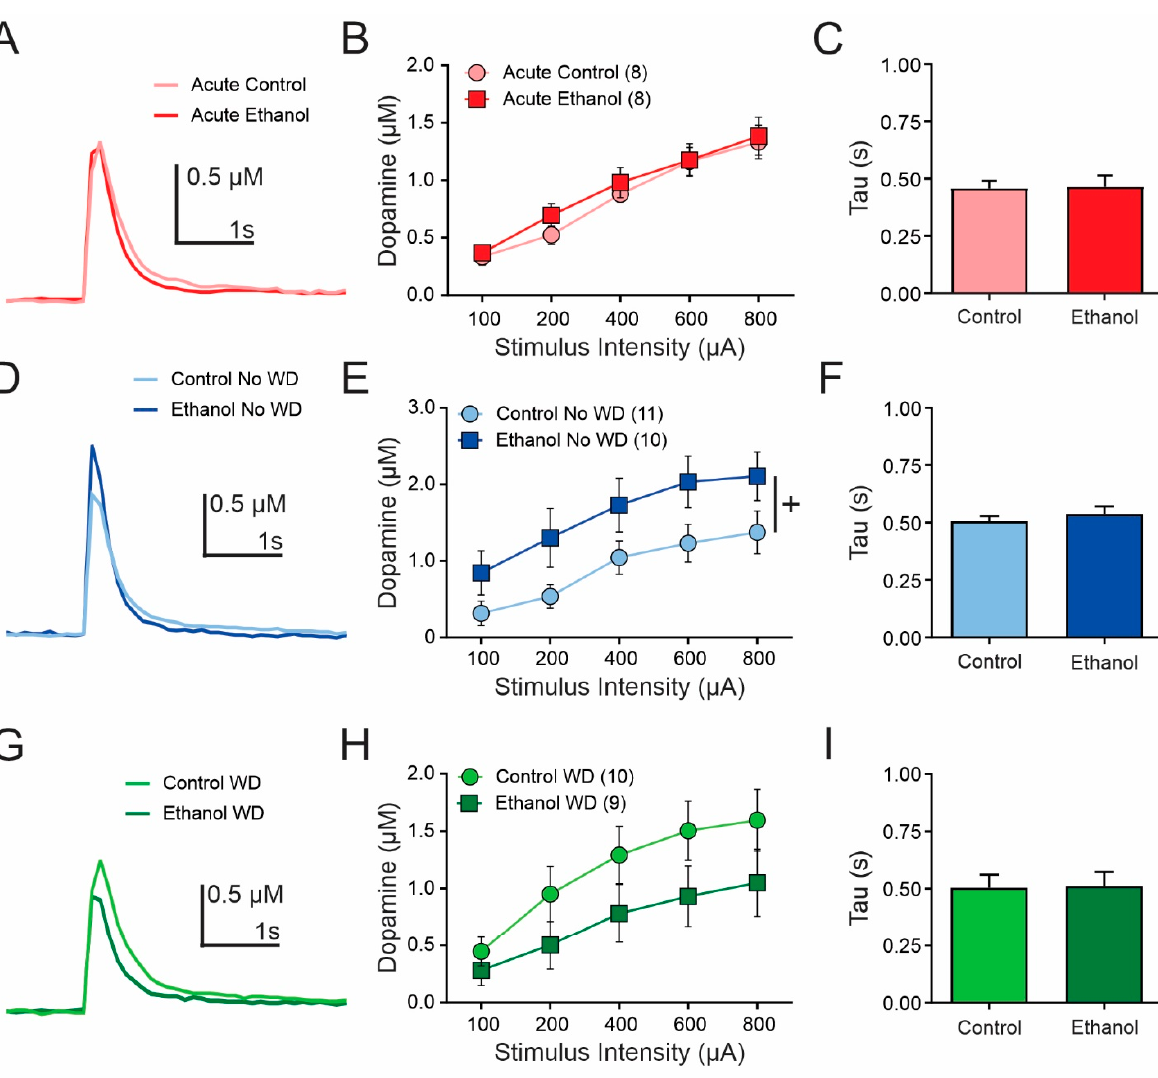
Figure 3. Two-bottle choice ethanol consumption did not significantly alter maximal dopamine re- lease. One day of ethanol consumption ( A , B ) did not alter maximal dopamine release or dopamine transient decay rate ( C ). Four weeks of two-bottle choice drinking resulted in a trend towards in- creased maximal dopamine release ( D , E ) but no difference in dopamine transient decay rate ( F ). In the WD group, neither dopamine release ( G , H ) nor dopamine transient decay rate ( I ) differed from their respective controls. The DOPAC/DA ratio ( J ) trended towards a decrease in the ethanol No WD group compared to all the other groups. Number of slices indicated in parentheses from 8–10 mice per treatment group for FSCV experiments. n = 4–6 mice per group for DOPAC/DA ratios. + p < 0.10. 2.3. Chronic Ethanol Consumption Increases D2 Dopamine Autoreceptor Sensitivity